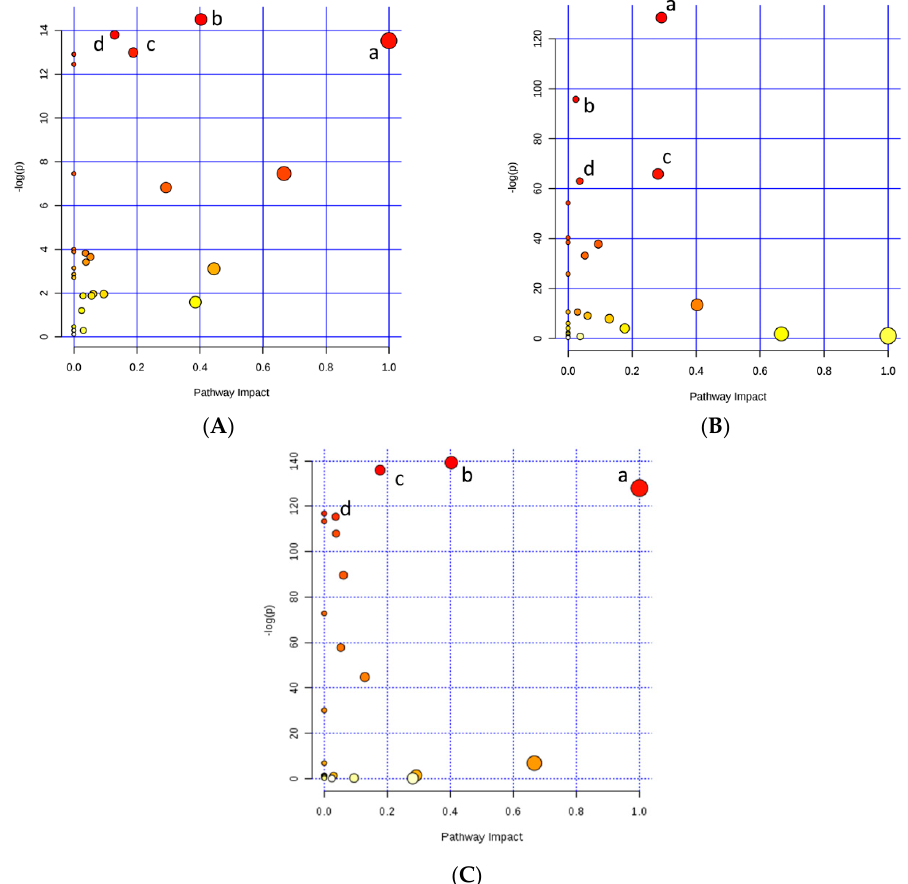
Figure 3. Metabolomics pathways of the meat extract revealed significant differences in the drawn pathway according to ( A ) Precocity: high precocity (HP) and low precocity (LP); ( B ) Selection traits: Growth and Precocity; and ( C ) Intensity of selection: High and Low. In the scatter plot, the x-axis indicates the impact on the pathway whereas the y-axis indicates significant changes in the pathway by detected metabolites. Darker color and larger size represent higher p -values from the enrichment analysis and greater impact from the pathway topology analysis,